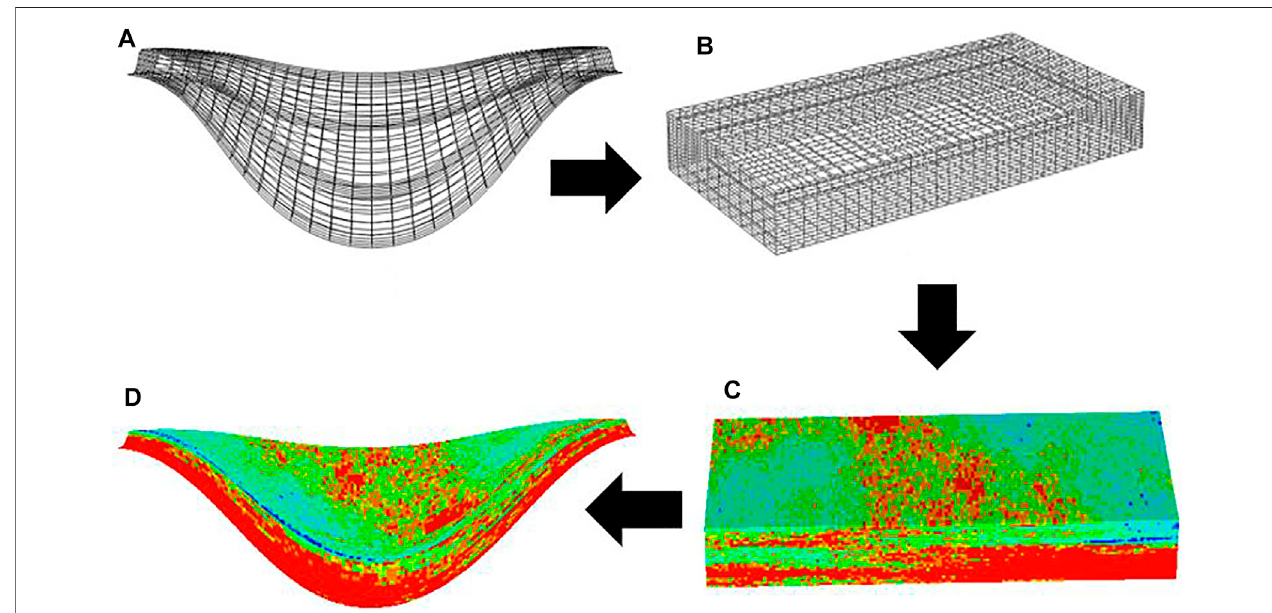
FIGURE6| Outlineofpropertymodeling: (A) pointbarcurvilinearGrid (B) Orthogonalgridtransformation (C) Geostatisticalsimulationontransformedgrid (D) back transformation, indicating the 3D distribution of reservoir properties in the fi nal point bar model.